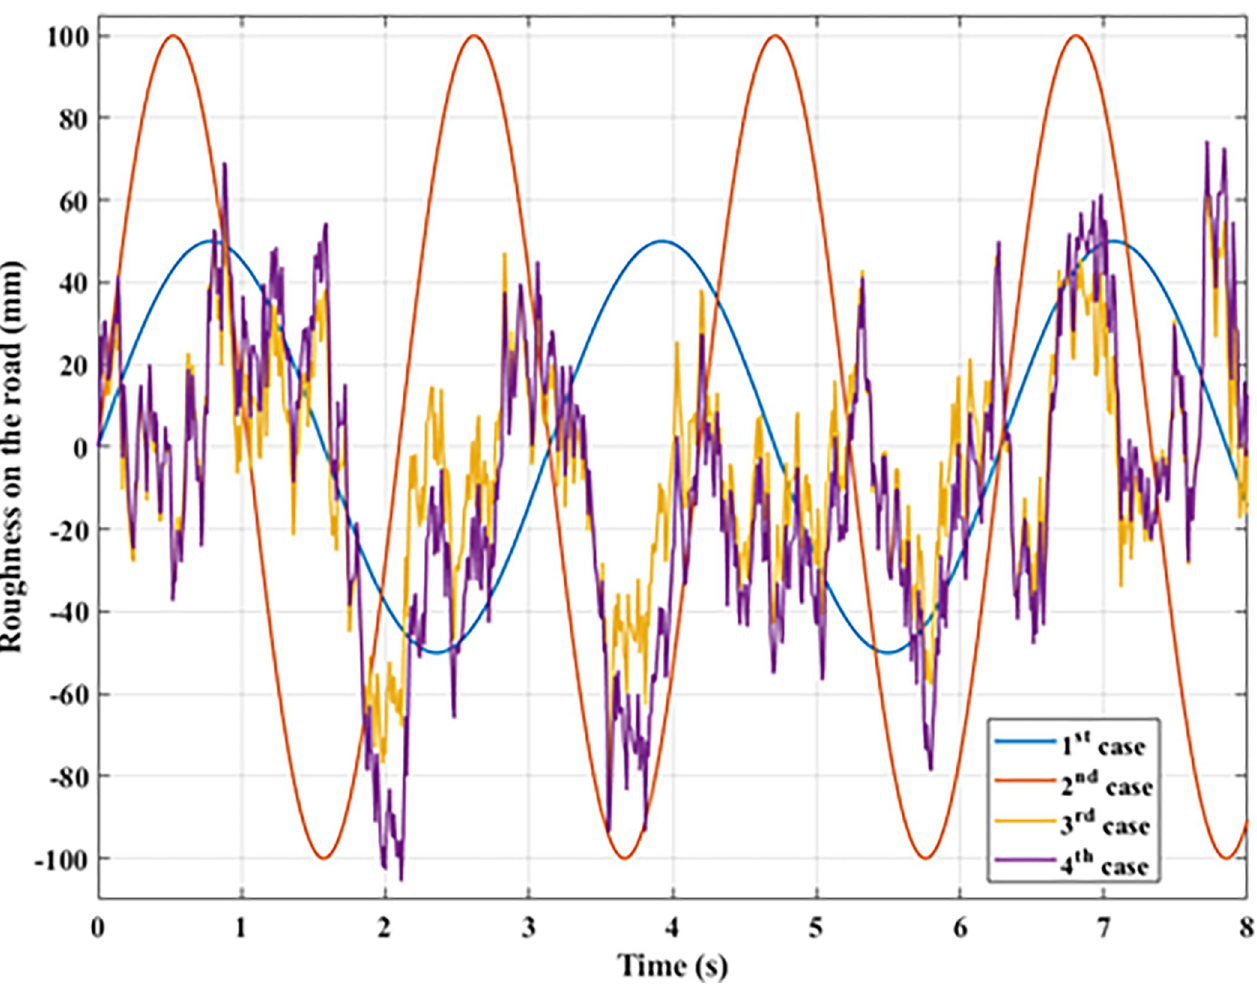
Fig 4. Roughness on the road.